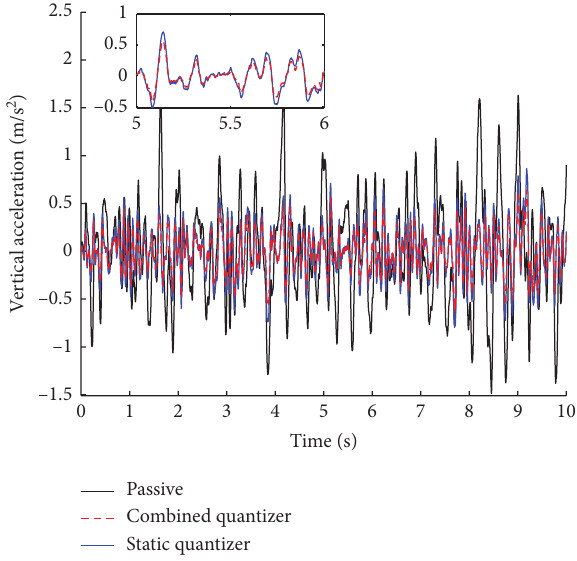
Figure 5: Sprung mass vertical acceleration.